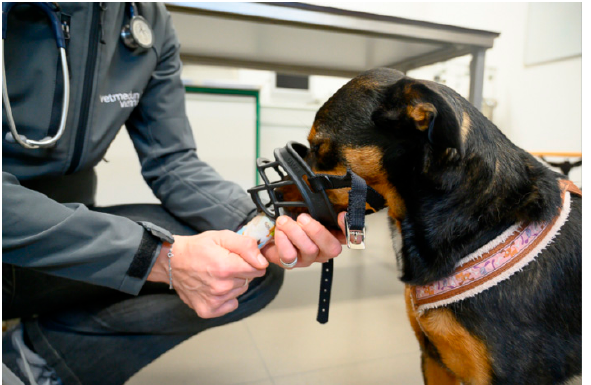
Figure 7. Muzzles increase safety. Food can be used to entice the dog to place its nose into the muzzle and should be offered repeatedly during wearing in order to create positive associations. Photo: Christine Arhant, Vetmeduni Vienna.